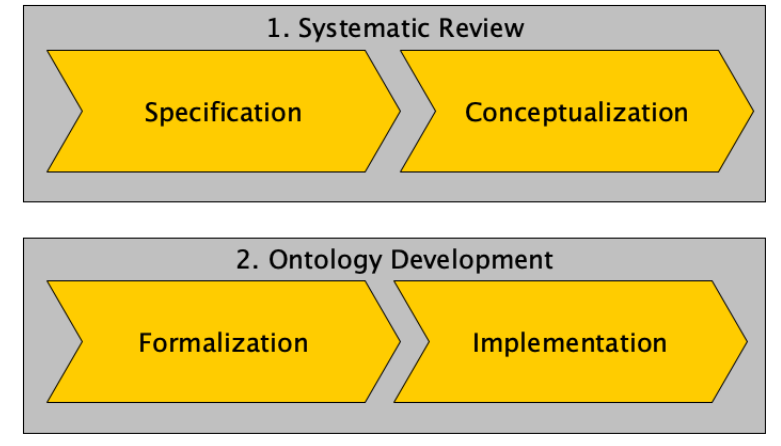
Figure 3. Ontology creation process.